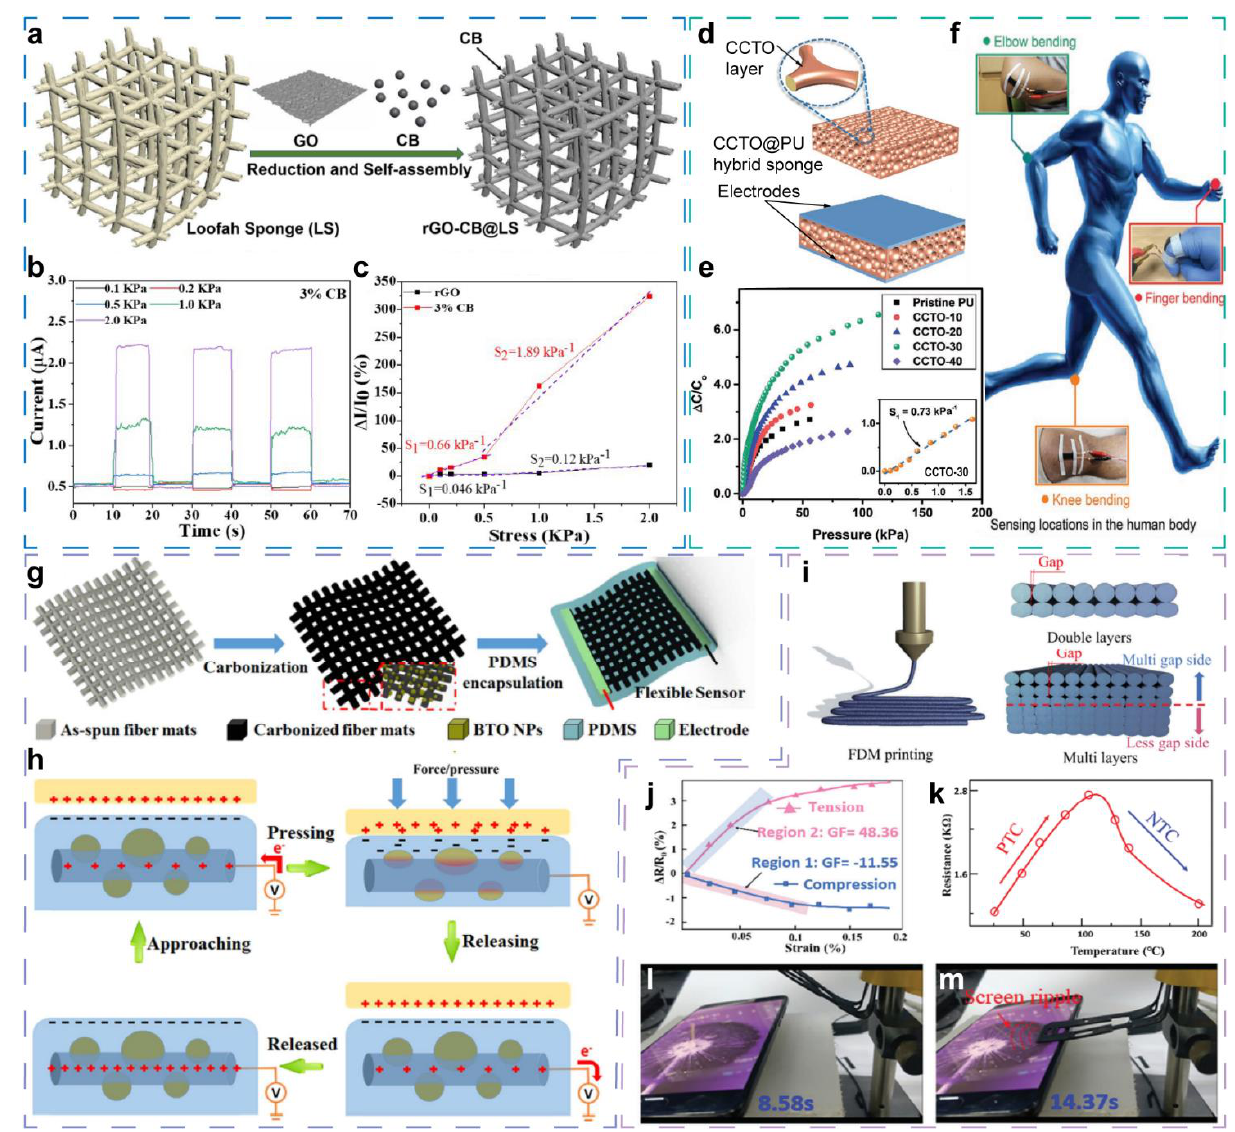
Figure 2. ( a – h ) Multifunctional sensors enhanced by 0-D components, and ( i – m ) the integrated sensor-actuator with sensibility to mechanical stimulus and temperature. ( a ) Fabrication processes and device structure of the rGO@LS conductive composite resistive sensor enhanced by CB nanoparticles. ( b ) The current response of rGO-CB@LS sensor under different pressure. ( c ) The normalized current response of the sensors with CB addition of 0% and 3%, respectively. Reproduced with permission. [29] Copyright 2020, American Chemical Society. ( d ) Schematic illustration of structure of CCTO@PU hybrid sponge and the capacitive sensor. ( e ) The normalized capacitance response curves with different CCTO loading percentages. The inset exhibits the sensitivity of CCTO-30-based sensor below 1.6 kPa. ( f ) Schematic illustration of multifunctional application for detecting human actions. Reproduced with permission. [30] Copyright 2020, Wiley-VCH. ( g ) Fabrication processes and device structure of the PAN-C/BTO composite sensor. ( h ) Self-powered working mechanism of PAN- C/BTO composite sensor. Reproduced with permission. [50] Copyright 2015, American Chemical Society. ( i ) Assembly processes and the gradient gap structures of the integrated sensor-actuator. ( j , k ) Strain and temperature detection of the sensor-actuator, respectively. ( l , m ) The process of mimicking the finger action of touching screen. Reproduced with permission. [27] Copyright 2020,